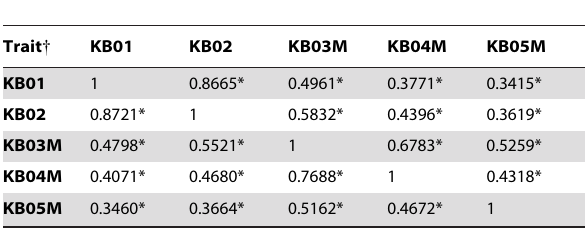
Table 2. Genetic (lower diagonal) and phenotypic (upper diagonal) correlations for Karnal bunt (KB) across the different